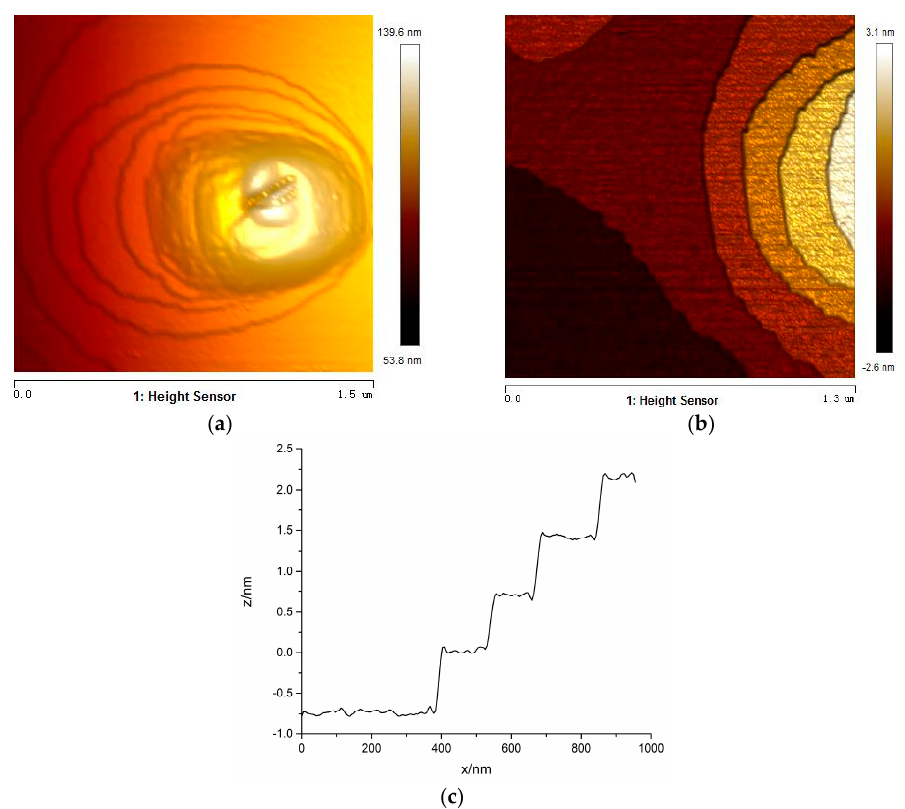
Figure 6. ( a ) Atomic force microcopy (AFM) images of growth hillock of {0 1 − 1 4} planes; ( b ) magnified AFM images of growth steps of {0 1 − 1 4} planes; ( c ) growth steps flow curve of {0 1 − 1 4} planes.